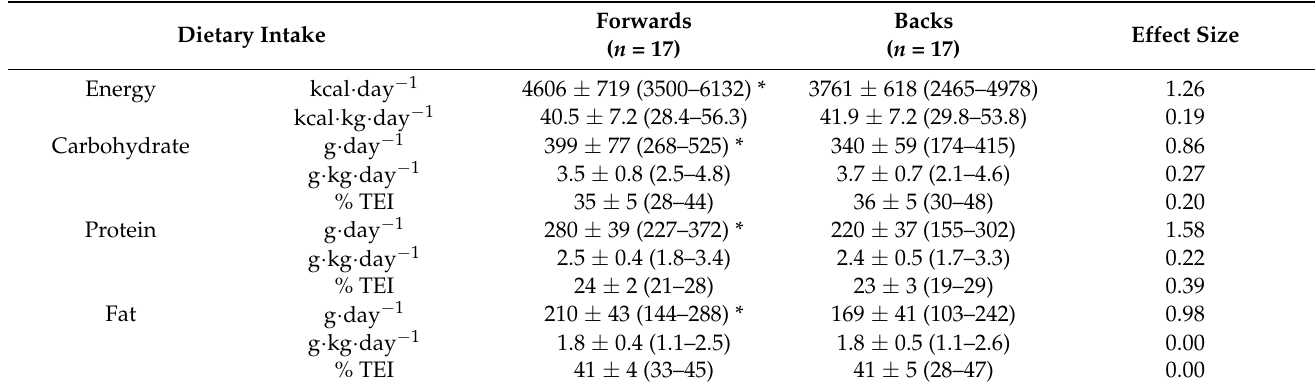
Mean ± standard deviation (range). % TEI = percentage of total energy intake. * Indicates a significant difference between forwards and backs ( p < 0.05).